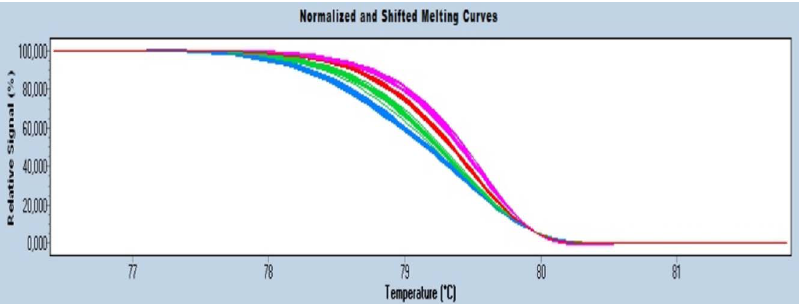
Fig. 3. HRM melting profiles for P5CS . The melting curve for Rosa wichurana is part of the green cluster; Rosa ‘Yesterday’ is part of the red cluster. Both clusters also contain curves of the siblings. Blue and pink clusters contain only the melting curves of siblings.